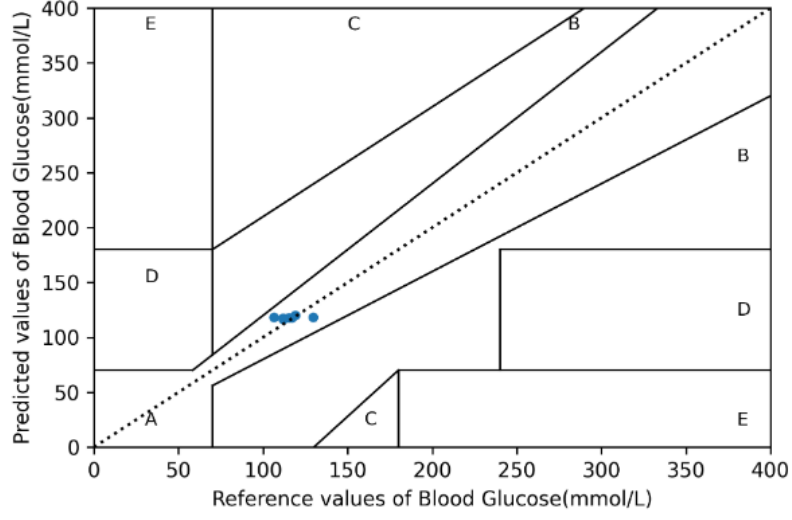
Figure 7. Clarke error